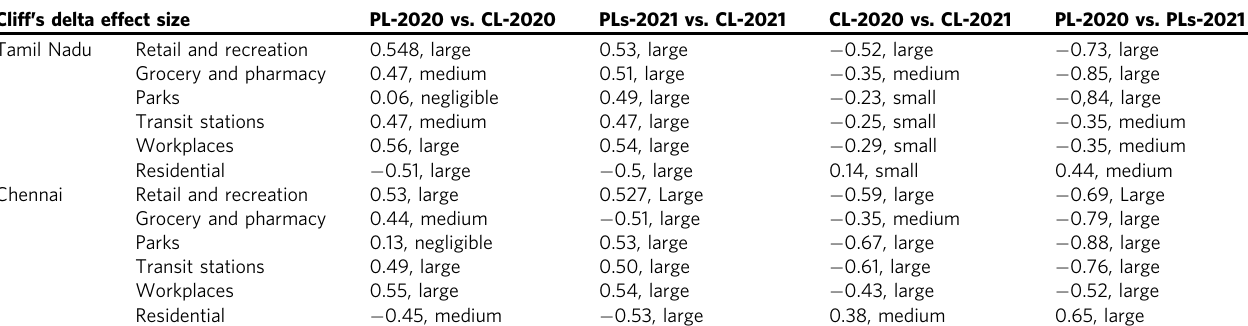
Table 4 Effect size for various group comparisons among various phases of lockdown during fi rst and second waves of COVID-19 in the state of Tamil Nadu and city of Chennai.